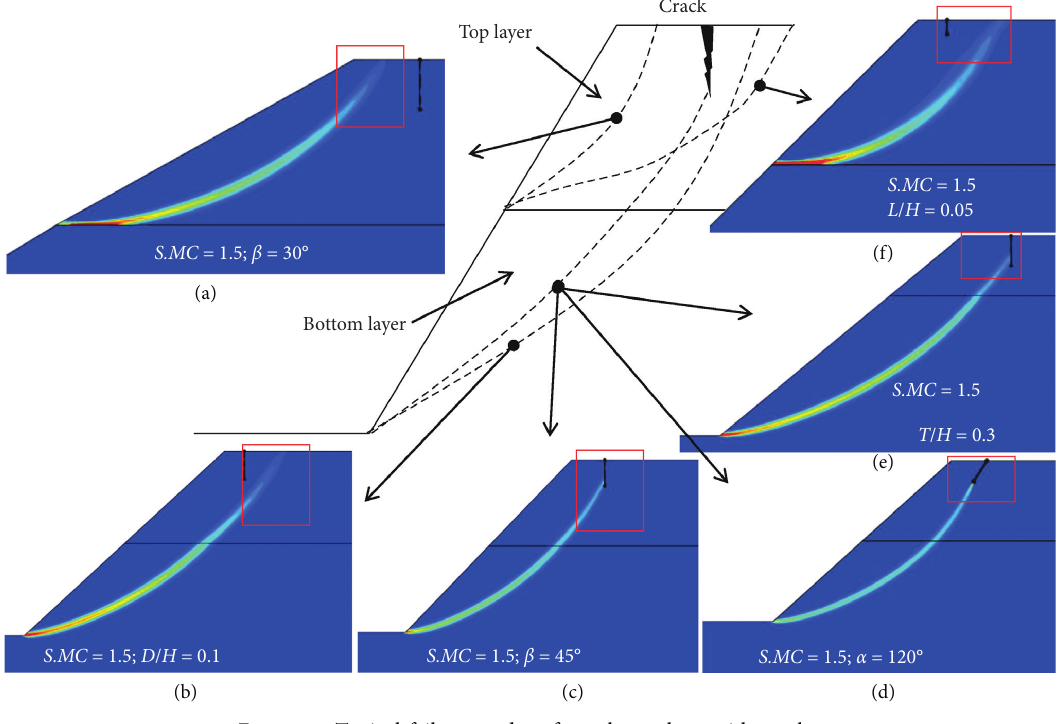
Figure 7: Typical failure modes of two-layer slope with